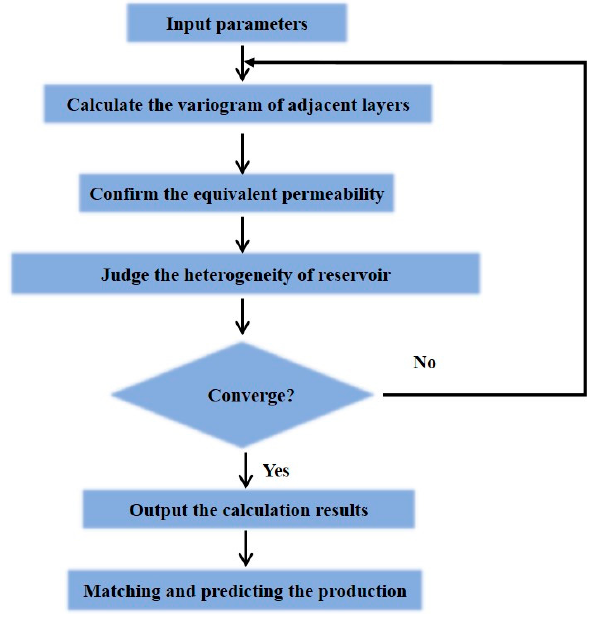
Figure 3. The flow chart of simulation. Table 2. Parameter list for simulations.